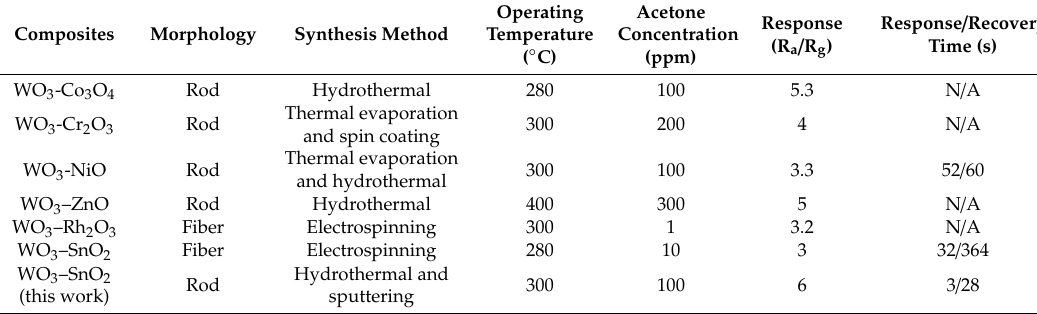
Figure 8. Dynamic gas-sensing response–recovery curves of various nanorods upon exposure to different acetone vapor concentrations (100 to 1000 ppm): ( a ) WO 3 , ( b ) WS-1, ( c ) WS-2, and ( d ) WS-3 nanorods. ( e ) Gas-sensing response values vs. acetone vapor concentration for various nanorods. ( f ) Cyclic gas-sensing response curves for the WS-1 nanorods exposed to 500 ppm acetone vapor. ( g ) Gas-sensing selectivity of the WS-1 nanorods exposed to 100 ppm of CH 3 COCH 3 , NH 3 , and H 2 , and 5 ppm of NO 2 . Table 1. Summary of the acetone gas-sensing performances of various WO 3 -based composites operating in the temperature range of 280–400 °C [22–27]. N/A, Not available.